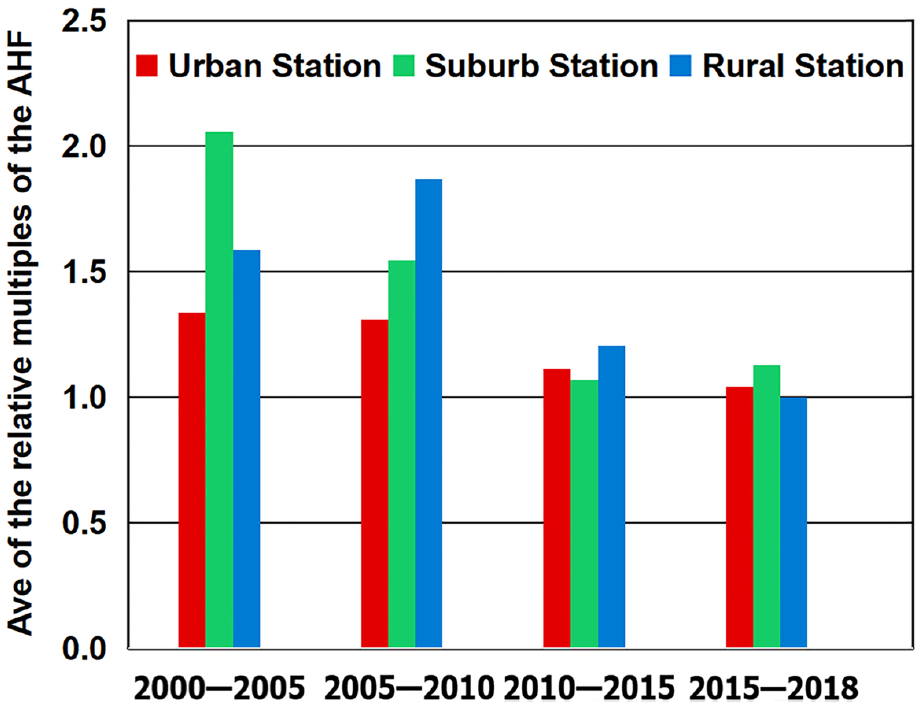
Figure 7. Average of the relative multiples of the AHF at three different types of station in a 5 km radius buffer zone around the meteorological stations (comparative analysis every five years).